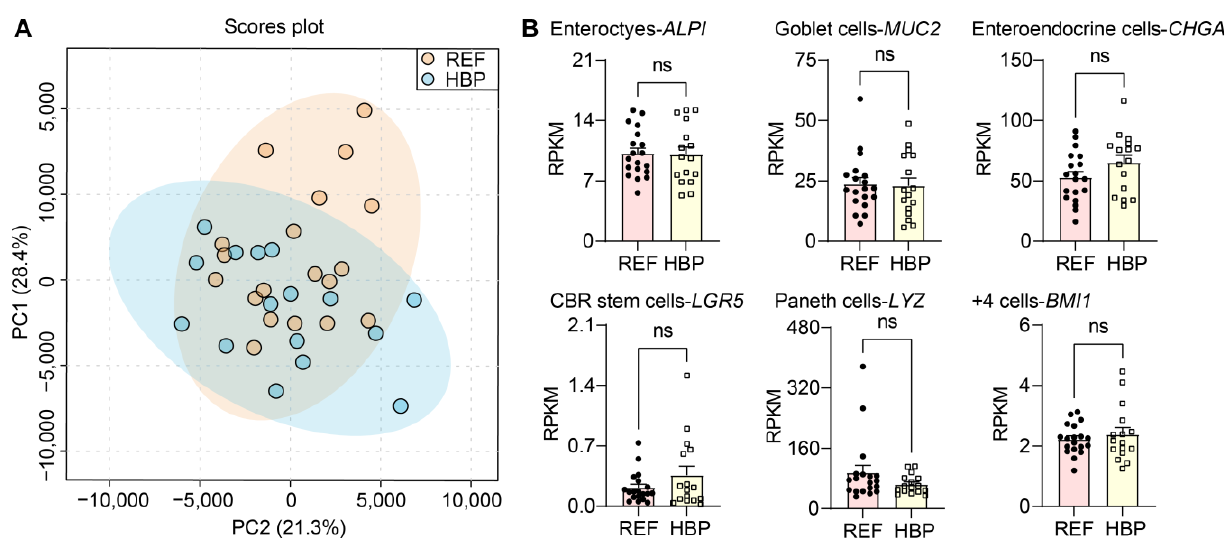
Figure 1. Quality control of transcriptomic methods and colon sampling. Transcriptome profiling. ( A ) Principal component analysis (PCA) plot based on complete expression profiles. Blue region is for 95% confidence interval of REF group, yellow region is for 95% confidence interval of HBP